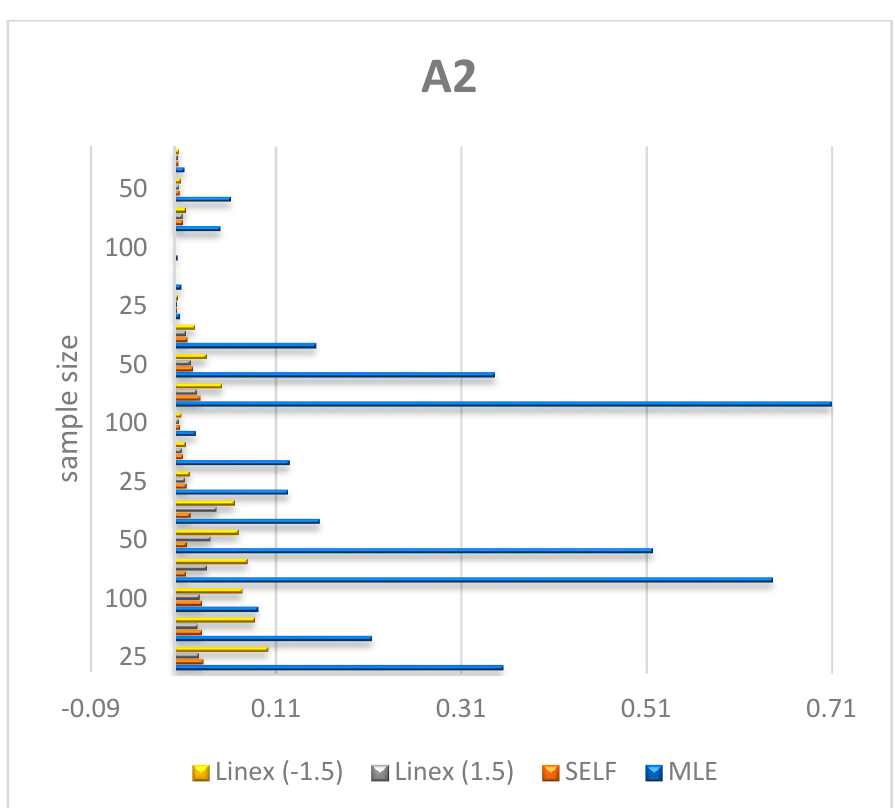
Figure 8. Plot A2 of 𝜇 by results in Table 1.